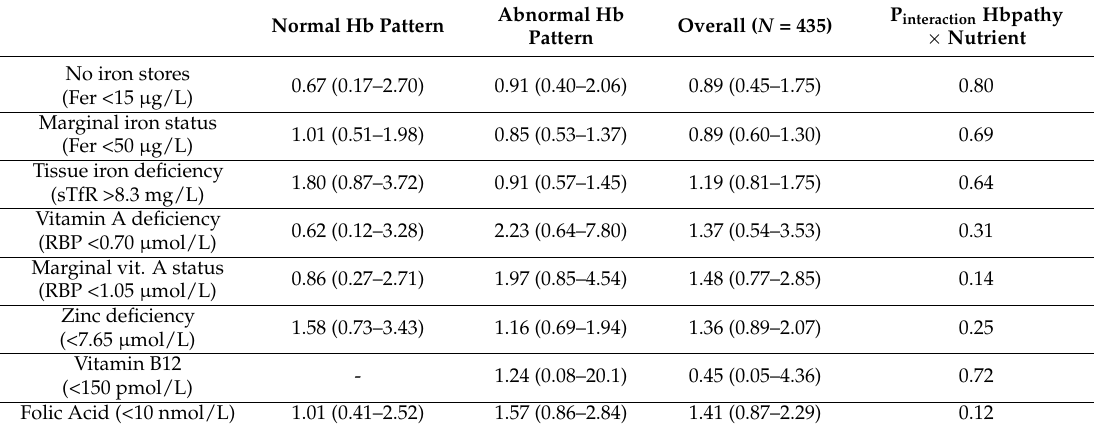
Table 5. Unadjusted univariate odds ratios of iron and other vitamin and mineral deficiencies to anemia in women ( N =